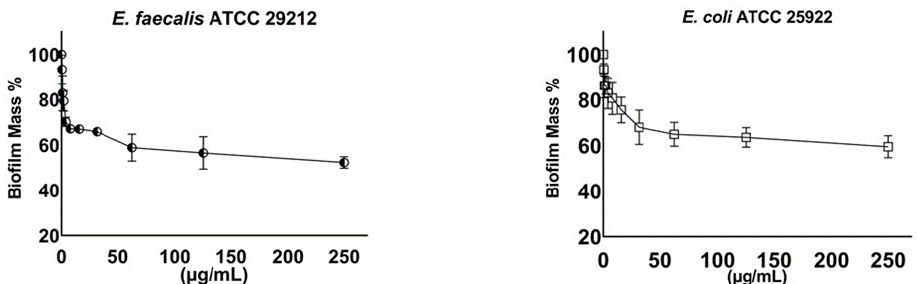
Figure 5. Antibiofilm activity of kaempferol-3- O - α - L - (2″,4″ -di- E-p -coumaroyl)-rhamnoside (com-